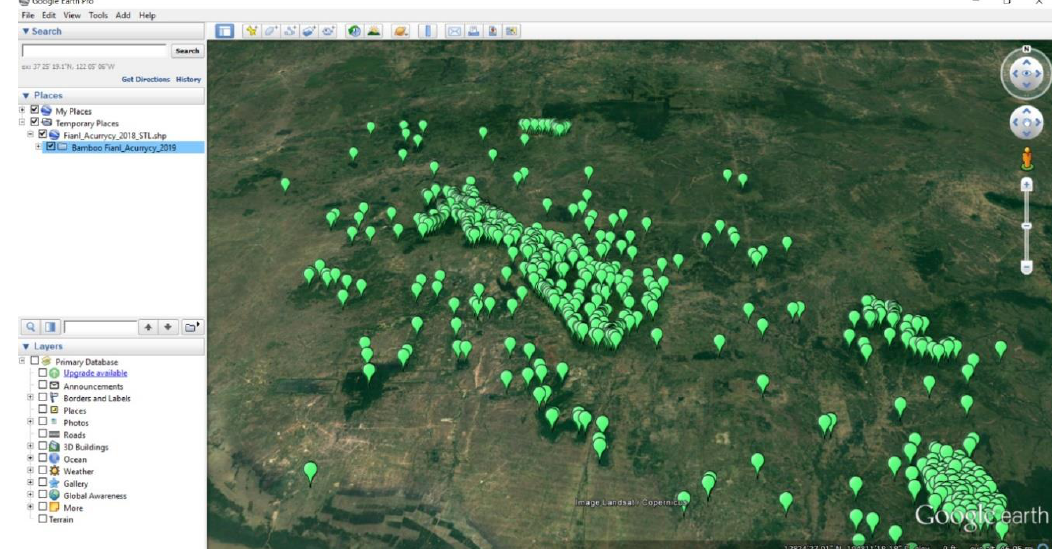
Figure 5. Imported reference points in Google Earth Pro for PBTC map accuracy assessment.